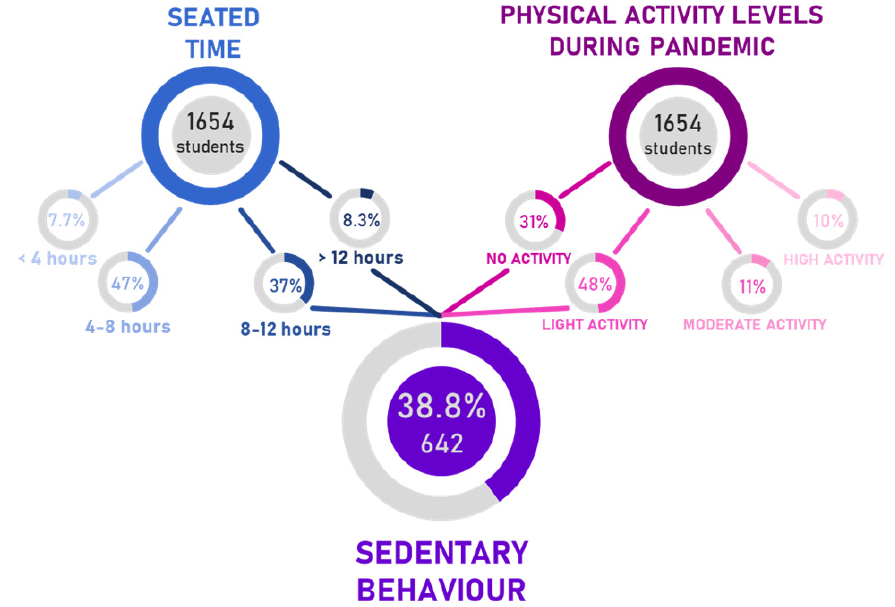
Figure 2. Estimation of sedentary participants depending on seated time and physical activity levels during the pandemic.